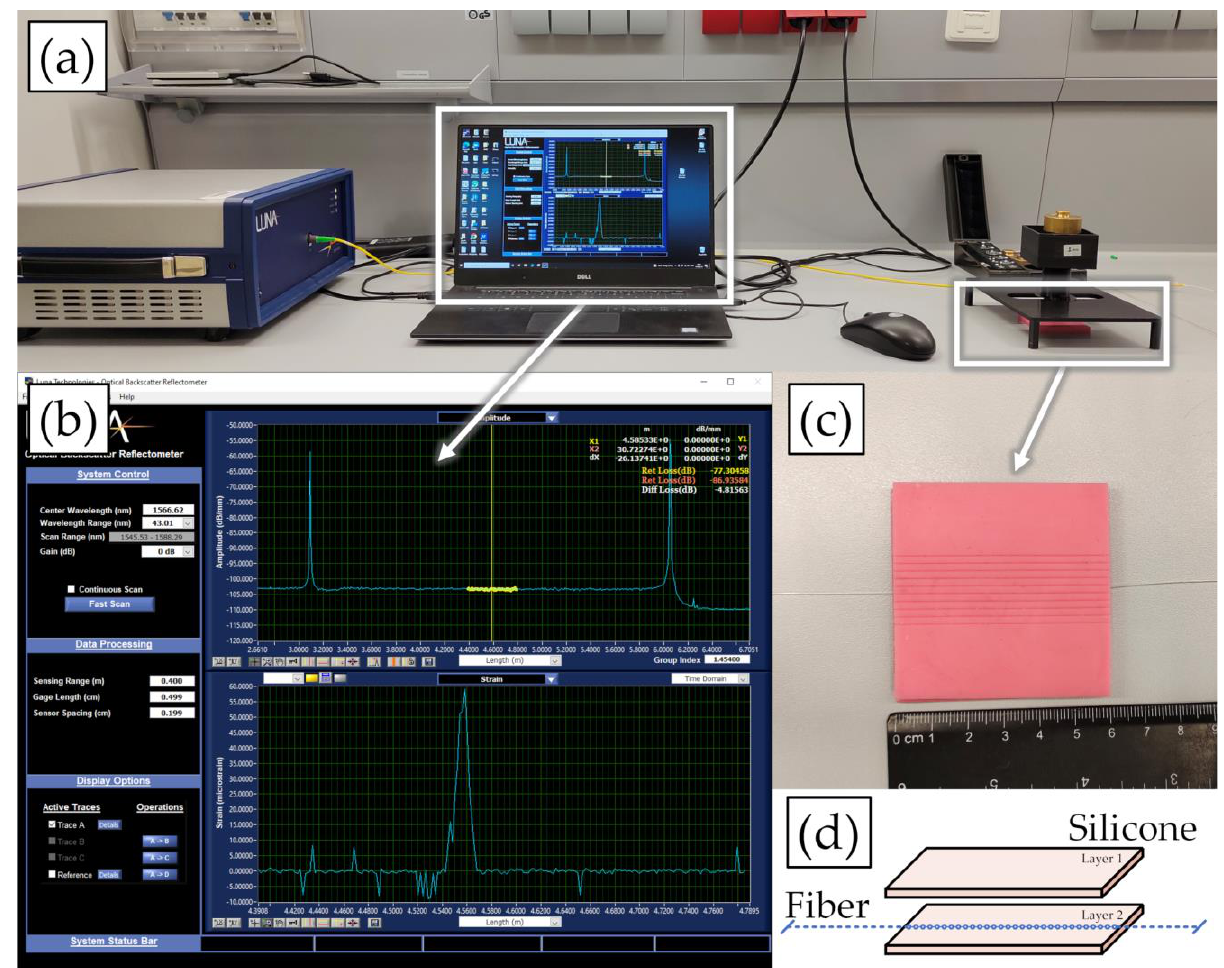
Figure 3. ( a ) Experimental setup. ( b ) The response on applied force. ( c ) One line fiber sandwiched between silicone layers. ( d ) Graphical representation of sandwiched fiber.